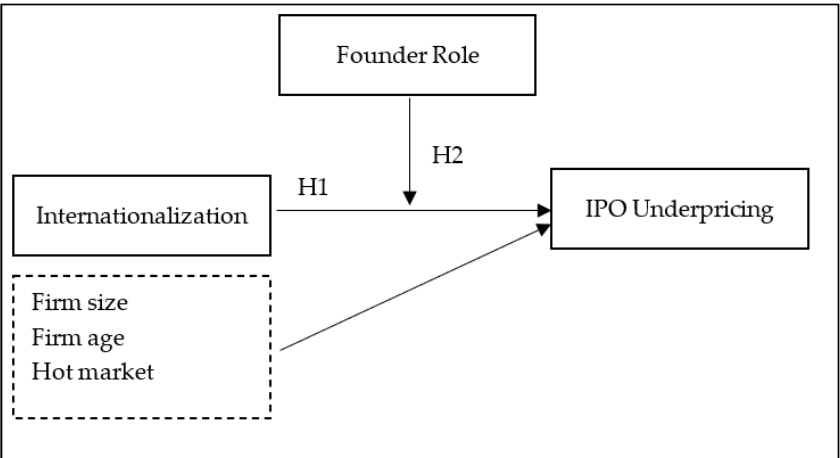
Figure 1 . Conceptual research framework . Source : Literature review . Figure 1. Conceptual research framework. Source: Literature